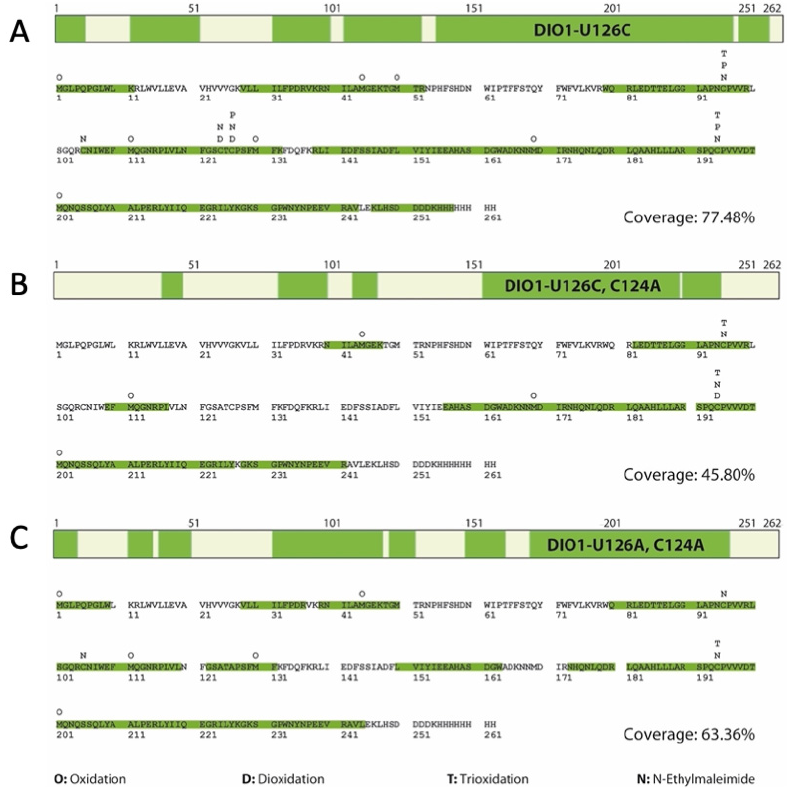
Figure A4. Mass spectrometry of recombinant DIO1 U126C variants. Coverage of the peptide sequence for the different mutants recombinantly expressed in Hi5 cells: ( A ): DIO1 U126C ; ( B ). DIO1 U126C/C124A ; ( C ). DIO1 U126A/C124A . Note the dehydro modifications at positions 124 and 126 in the DIO1 U126C mutant as well as the absence of sequence coverage around the catalytic center for the DIO1 U126C/C124A mutant.